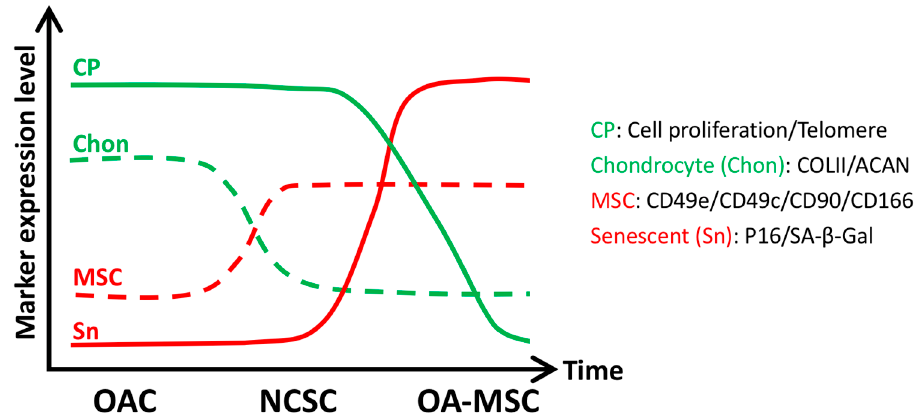
Figure 2. Comparisons of key characteristics among OACs, NCSCs, and OA-MSCs (Y-axis, marker expression level) during the aging process (X-axis, Time) [21,28]. Somatic cell markers including chondrocyte proliferation (telomere length) and differentiation (COLII/ACAN mRNA levels) de- crease as cells transition from OAC to NCSC to OA-MSC during aging. Markers for cell senescence (P16/SA- β -gal) and MSC (CD49e/CD49c/CD90/CD166) increase as cells transition from OAC to NCSC to OA-MSC during aging. OA: Osteoarthritis; OAC: osteoarthritic chondrocytes; NCSC: nor- mal cartilage stromal cell; OA-MSC: osteoarthritic-cartilage mesenchymal stromal cell.